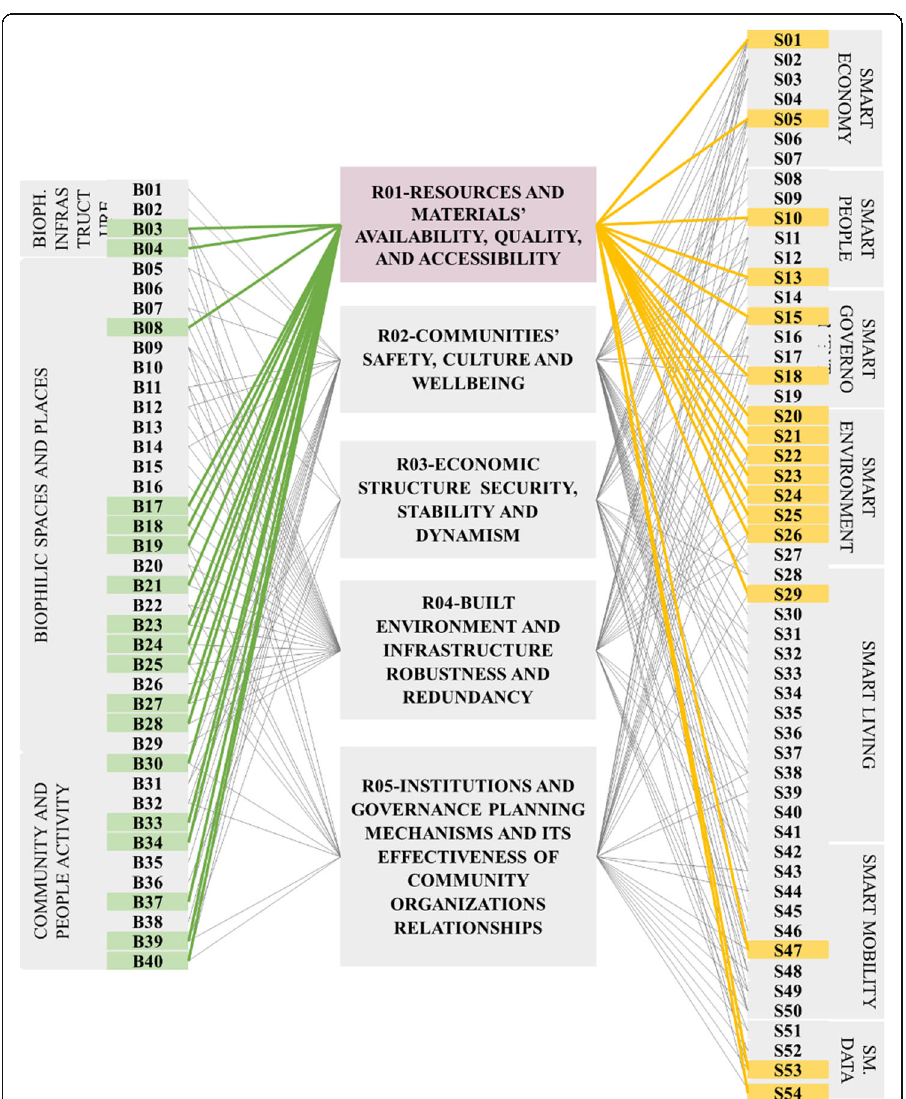
Fig. 5 Illustration for the cross-relationships between principles of urban resilience and indicators of biophilic and smart cities (showing R01 as